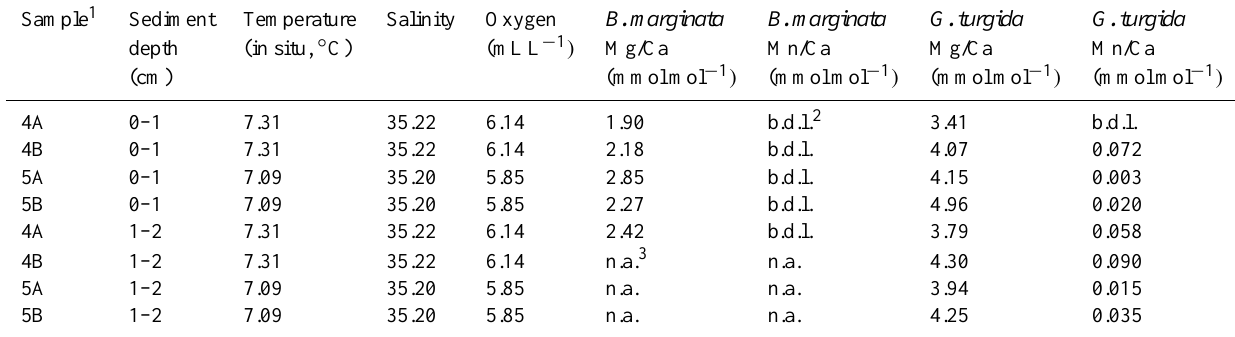
Table 2a. Water mass characteristics during sample collection in the Skagerrak and Mg/Ca and Mn/Ca for B. marginata and G. turgida . Sample 1